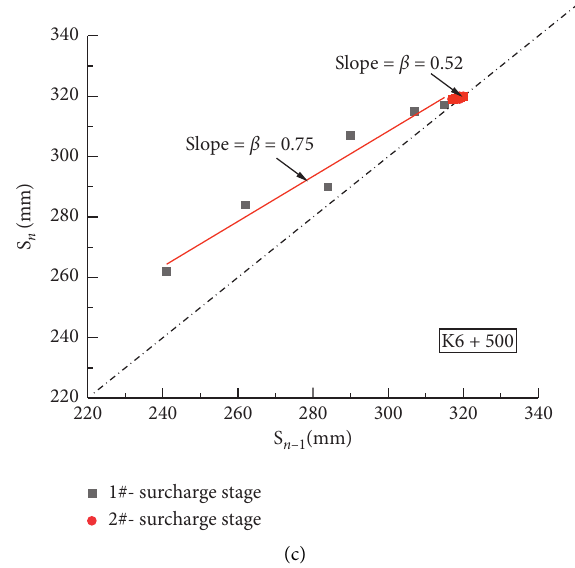
Figure 6: S − S n n − 1 relationship.